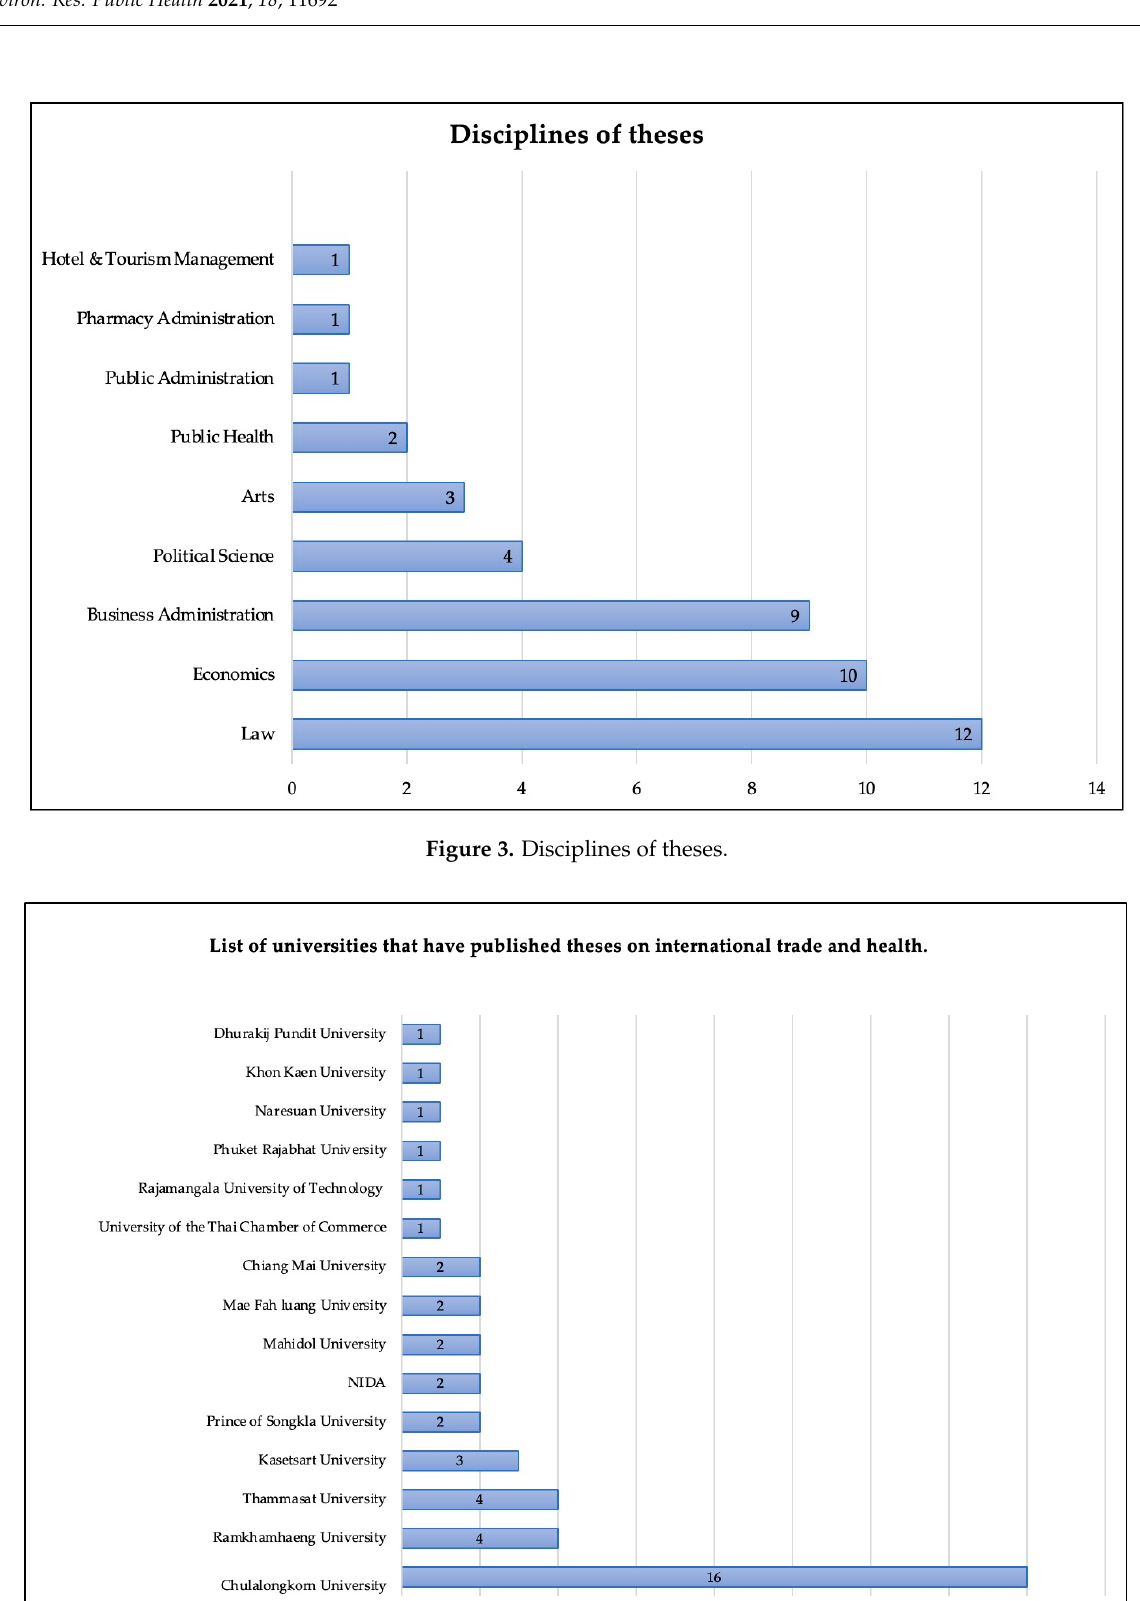
Figure 4. List of universities that have published theses on international trade and health.